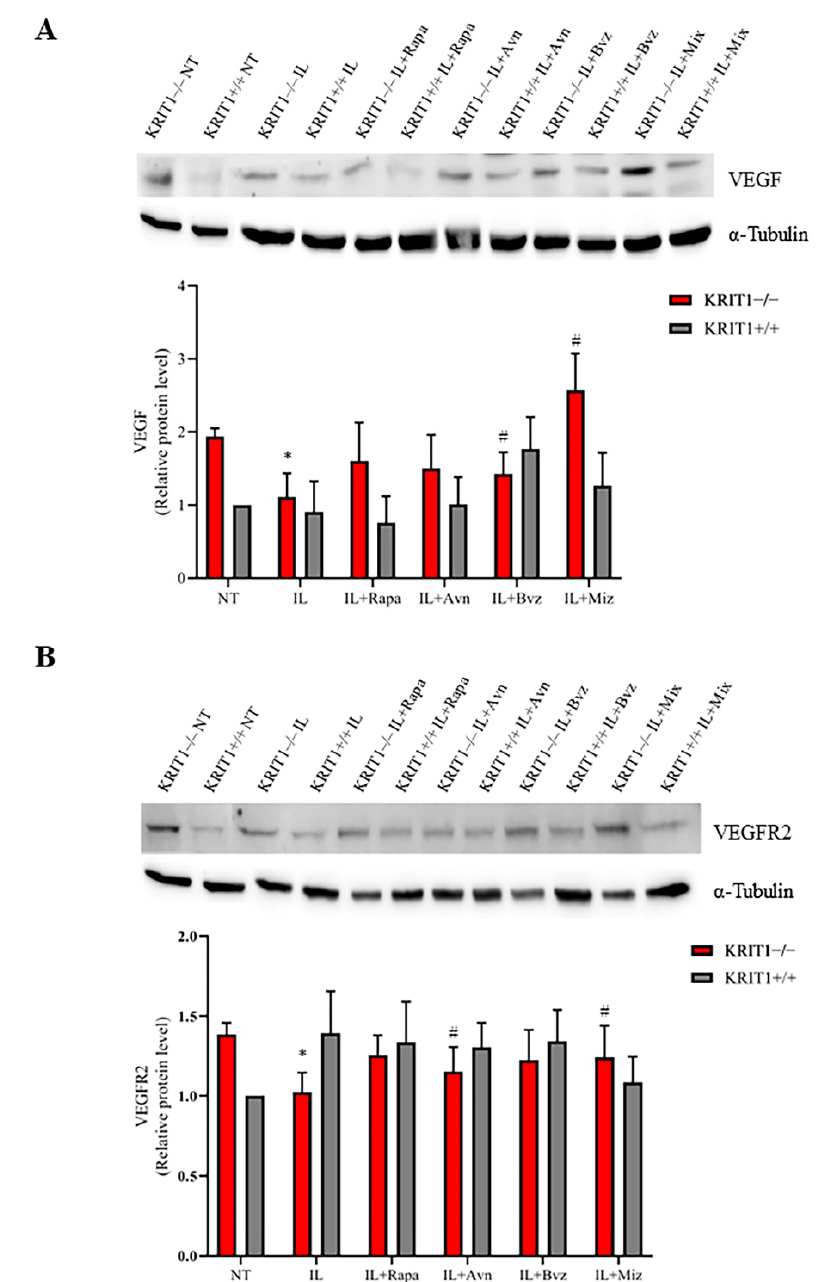
Figure 4. ( A ) Immunoblot analysis and representative histogram of vascular endothelial growth factor (VEGF) in KRIT1-knockout (KRIT1 − / − ) and KRIT1-overexpressing (KRIT1+/+) mouse embryonic fibroblasts (MEFs) untreated (Ctrl) or treated for 12 h with injectable nanoemulsions (ILs) loaded with rapamycin (Rapa), bevacizumab (Bvz), yeast avenanthramide I (Avn), or with a mixture of all three compounds (herein referred to as Mix) to a final concentration of: Avn = 15 µ g/mL (50 µ M), Rapa = 0.46 µ g/mL (500 nM), Bvz = 10 µ g/mL (70 nM). After treatment, cells were lysed, as described in Materials and Methods, and analyzed for the indicated proteins by Western blot (WB) analysis. ( B ) Immunoblot analysis and histogram representing the quantitative evaluation by densitometric analysis of VEGFR2 protein expression levels. Quantifications are relative protein level units referring to the average value obtained for KRIT1+/+ samples. α -tubulin was used as internal loading control for WB normalization. Statistical analysis: treatments vs. NT in KRIT − / − MEFs: # p < 0.1; * p <